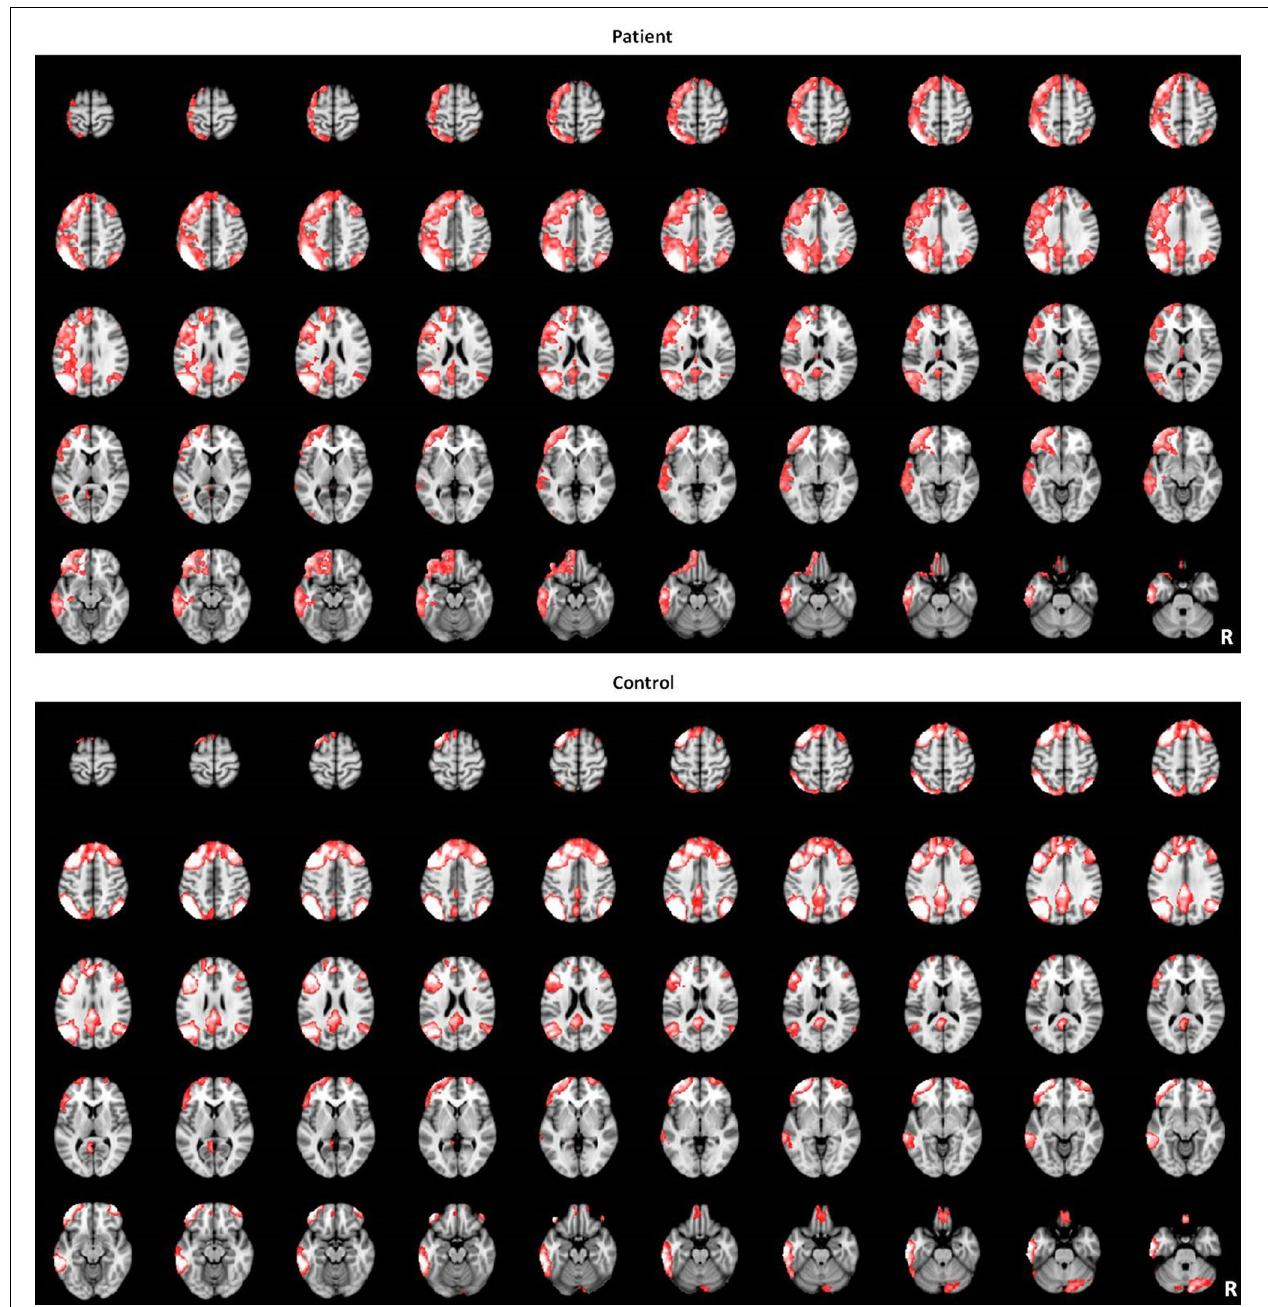
FIGURE 3 | The LFPN identified by group-level ICA in patients and controls